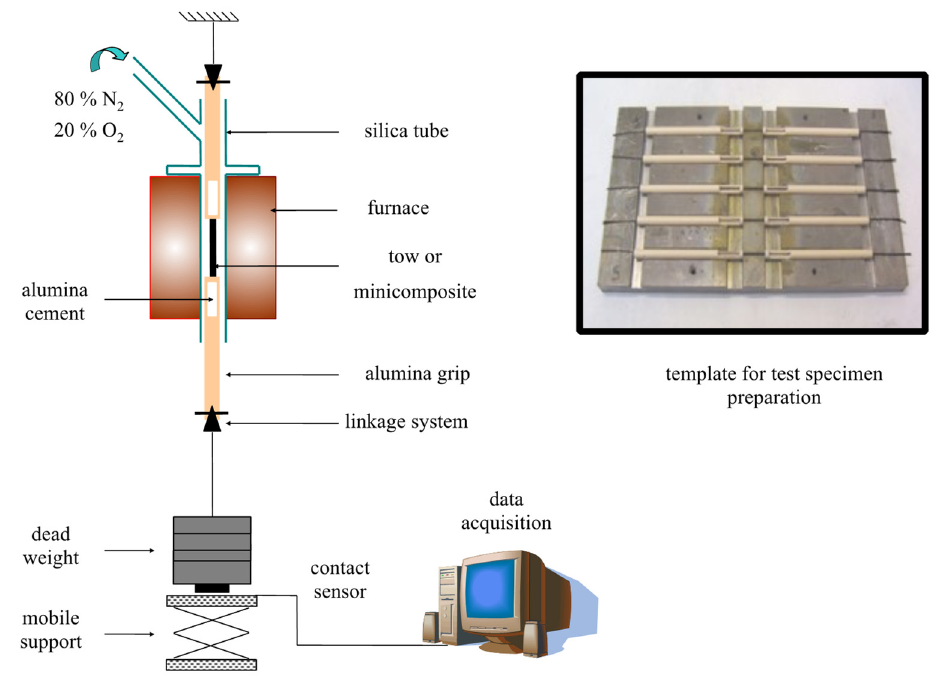
Figure 2. Machine for static fatigue testing of multifilament tows and minicomposites at high temperature. Additionally shown is the template used for specimen preparation and alignment of minicomposites within the alumina tubes.